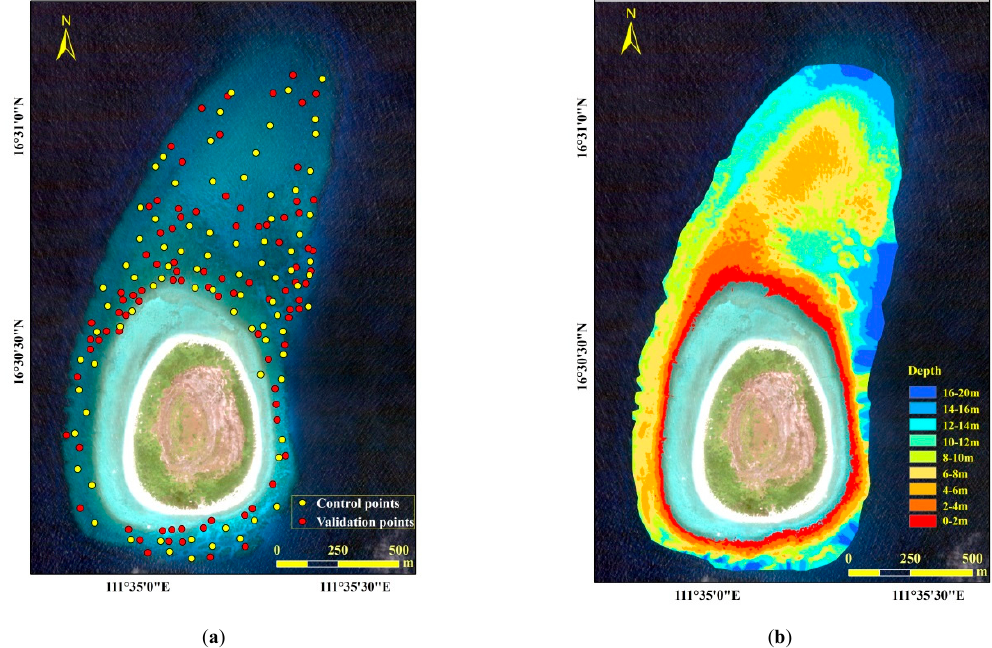
Figure 11. ( a ) Distribution of control and validation points; ( b ) depth inversion based on active and passive remote sensing combined.